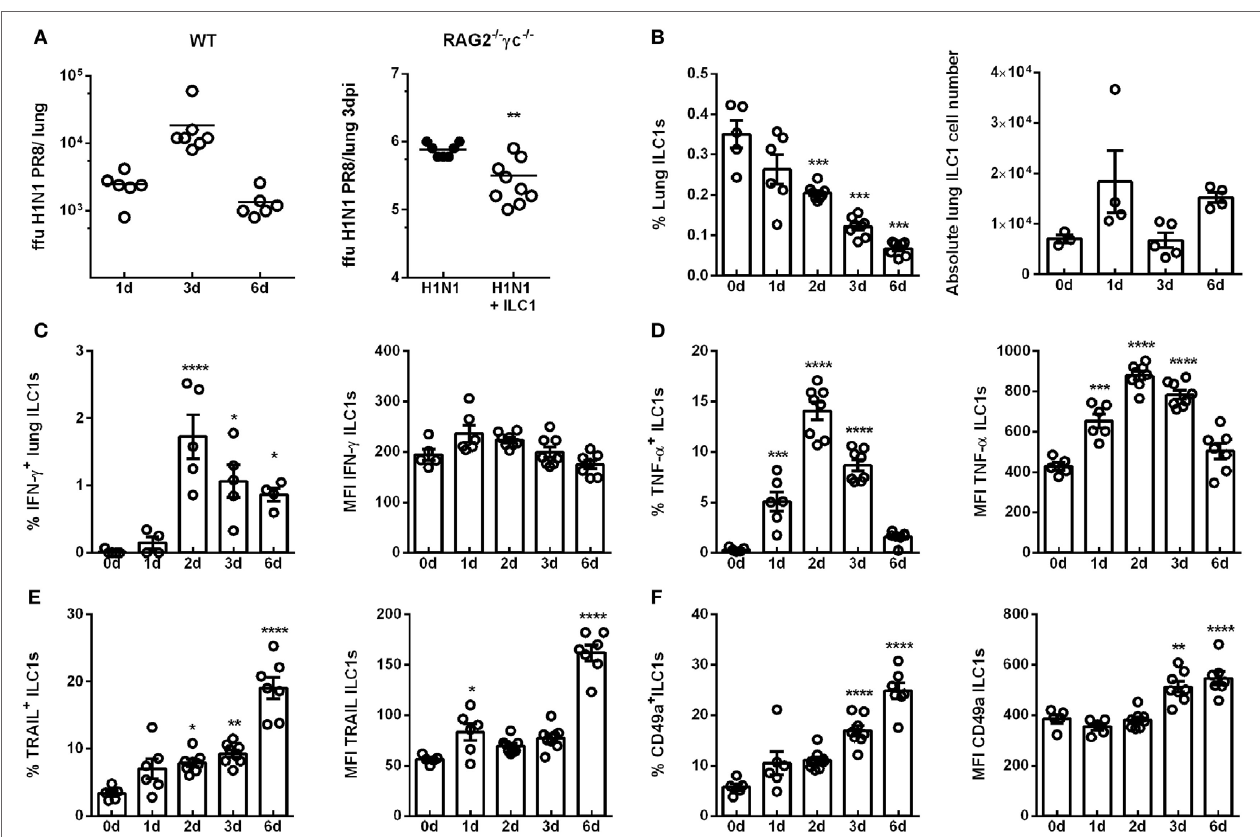
FigUre 1 | H1N1 infection leads to enhanced ILC1 activation and functionality. Wild-type mice and RAG2 − / − γ c − / − mice were infected i.n. with 2 × 10 3 ffu of the H1N1 PR8 strain. (a) Scatter plots represent viral loads of wild-type mice (left panel) and RAG2 − / − γ c − / − mice adoptively transferred with 2 × 10 5 in vitro -generated ILC1s/animal (right panel; n = 4–8) as determined by foci assay and depicted as ffu per lung at the indicated time points. Lymphocytes derived ex vivo from lungs of infected wild-type mice were incubated at 37°C in medium containing brefeldin and monensin for 3 h prior to flow cytometry staining of markers related to ILC1 activation and functionality. (B) Frequencies and absolute numbers of lung-derived ILC1s. Frequencies and mean fluorescence intensities (MFI) of (c) IFN- γ , (D) TNF- α , (e) TRAIL, and (F) CD49a expressing lung ILC1s. Shown is one out of three independent experiments ( n = 4–8). Bars with scatter plots represent MFI and range in frequencies with the horizontal line drawn at the mean. Asterisks denote significant values as calculated by nonparametric Mann–Whitney’s test (viral loads) or One-way ANOVA (frequency and MFI) as compared to uninfected samples; **** p ≤ 0.0001; *** p ≤ 0.001; ** p ≤ 0.01; * p ≤